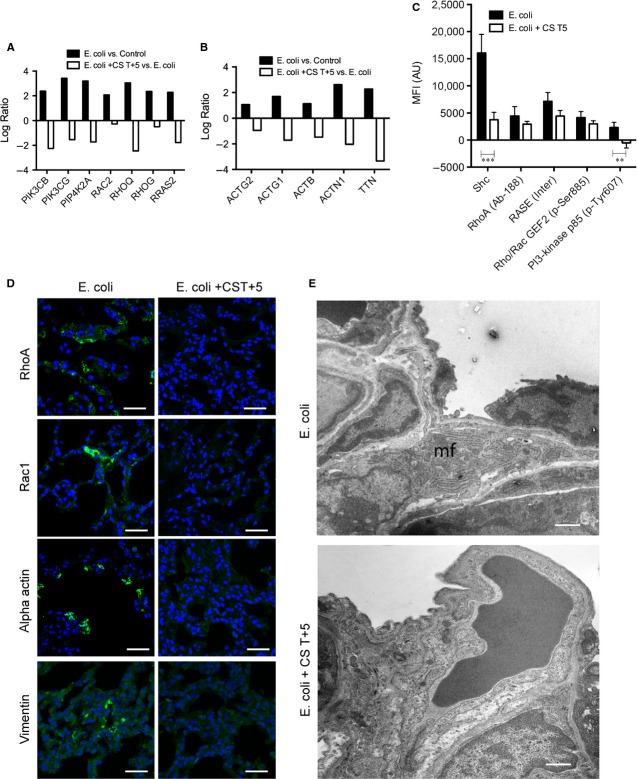
Compstatin treatment inhibits sepsis-induced myofibroblast differentiation and contractility. (A and B) Log ratio of microarray data showing expression of molecules involved in Rho/Rac and PI3K signalling (A) and actins and actin-binding proteins (B). Data are shown as log ratio mean of three biological replicates. (C) Phospho-antibody array analysis showing expression and phosphorylation of molecules involved in Rho/Rac and PI3K signalling. Mean fluorescence intensity (MFI) of the antibody spots are presented as mean ± S.E.M. of six replicates per experimental condition with unpaired two-tailed t-test. **P < 0.01; ***P < 0.001. (D) Immunocytochemical staining for detection of vimentin and α-actin-positive cells and for cell migration-relevant signalling molecules Rac and Rho in sepsis (Escherichia coli) versus compstatin-treated (E. coli + CS T+5) animals. Magnification: bars, 50 μm. (E) Transmission electron micrographs demonstrate the presence of cells with ultrastructural characteristics of a secretory myofibroblast (mf) within the alveolar walls of animals from sepsis (E. coli) but not compstatin-treated (E. coli + CS T+5) baboons. Magnification: bar, 1 μm.